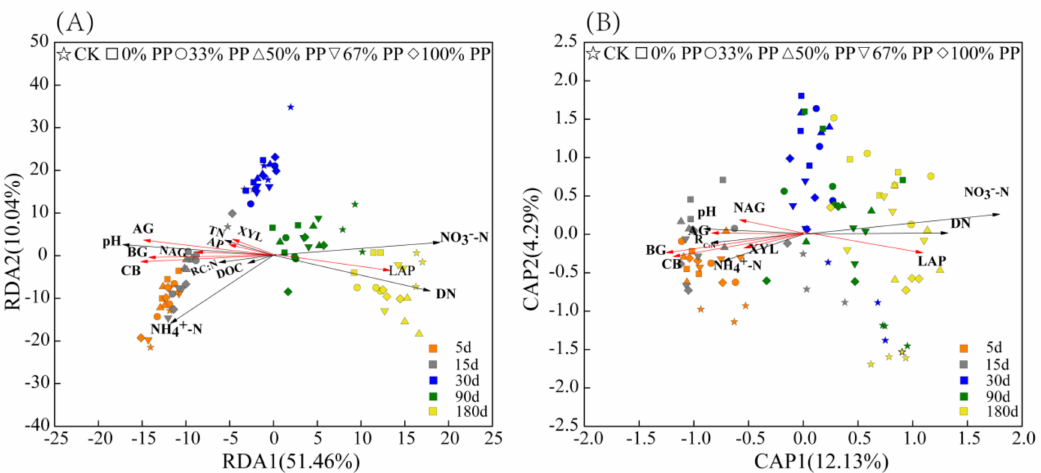
Figure 4. The redundancy analysis (RDA) ordination plots of the community compositions of bacteria ( A ) and fungal ( B ) communities. CK, with no litter; 0% PP, bamboo litter occupying at 0%; 33% PP, bamboo litter occupying at 33%; 50% PP, bamboo litter occupying at 50%; 67% PP, bamboo litter occupying at 67%; 100% PP, bamboo litter occupying at